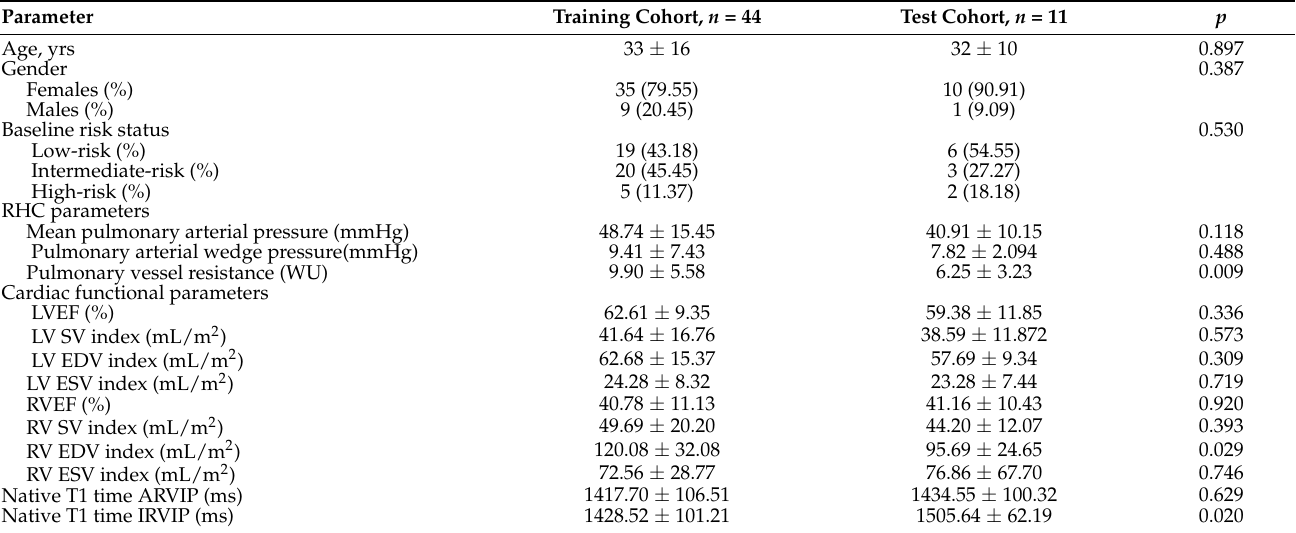
Table 2. Comparison of the clinical and conventional CMR characteristics in training and test